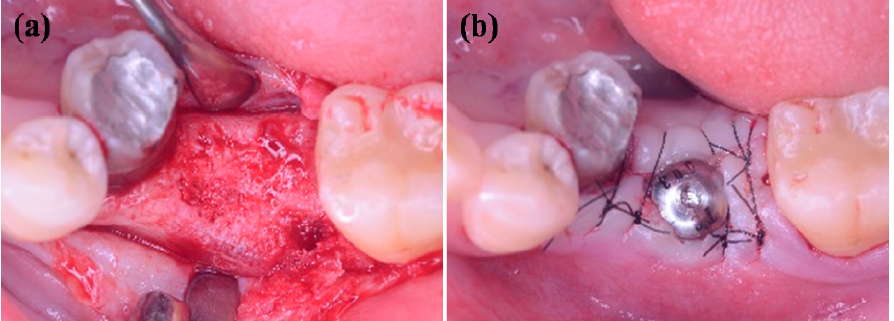
Figure 1. Surgical procedure of the investigated titanium (Ti) implant: ( a ) Full-thickness flap elevation and ( b ) dental implant